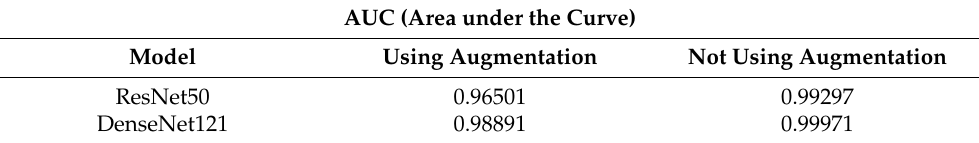
Table 2. Learning from zero with learning data